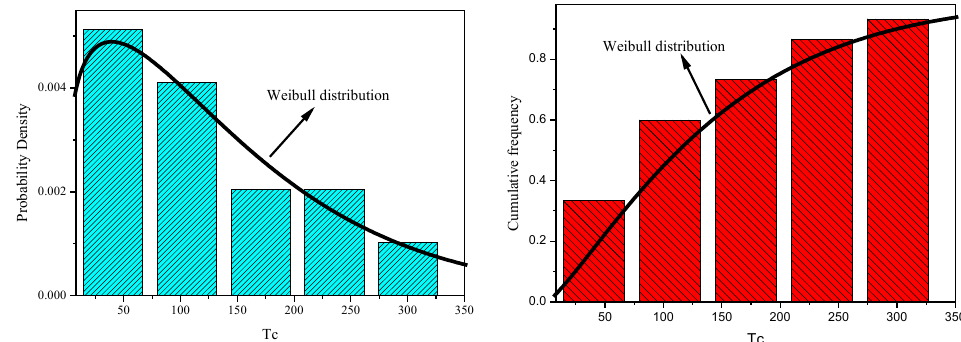
Figure 5. The frequency histogram and the cumulative frequency histogram of the time to catastrophic